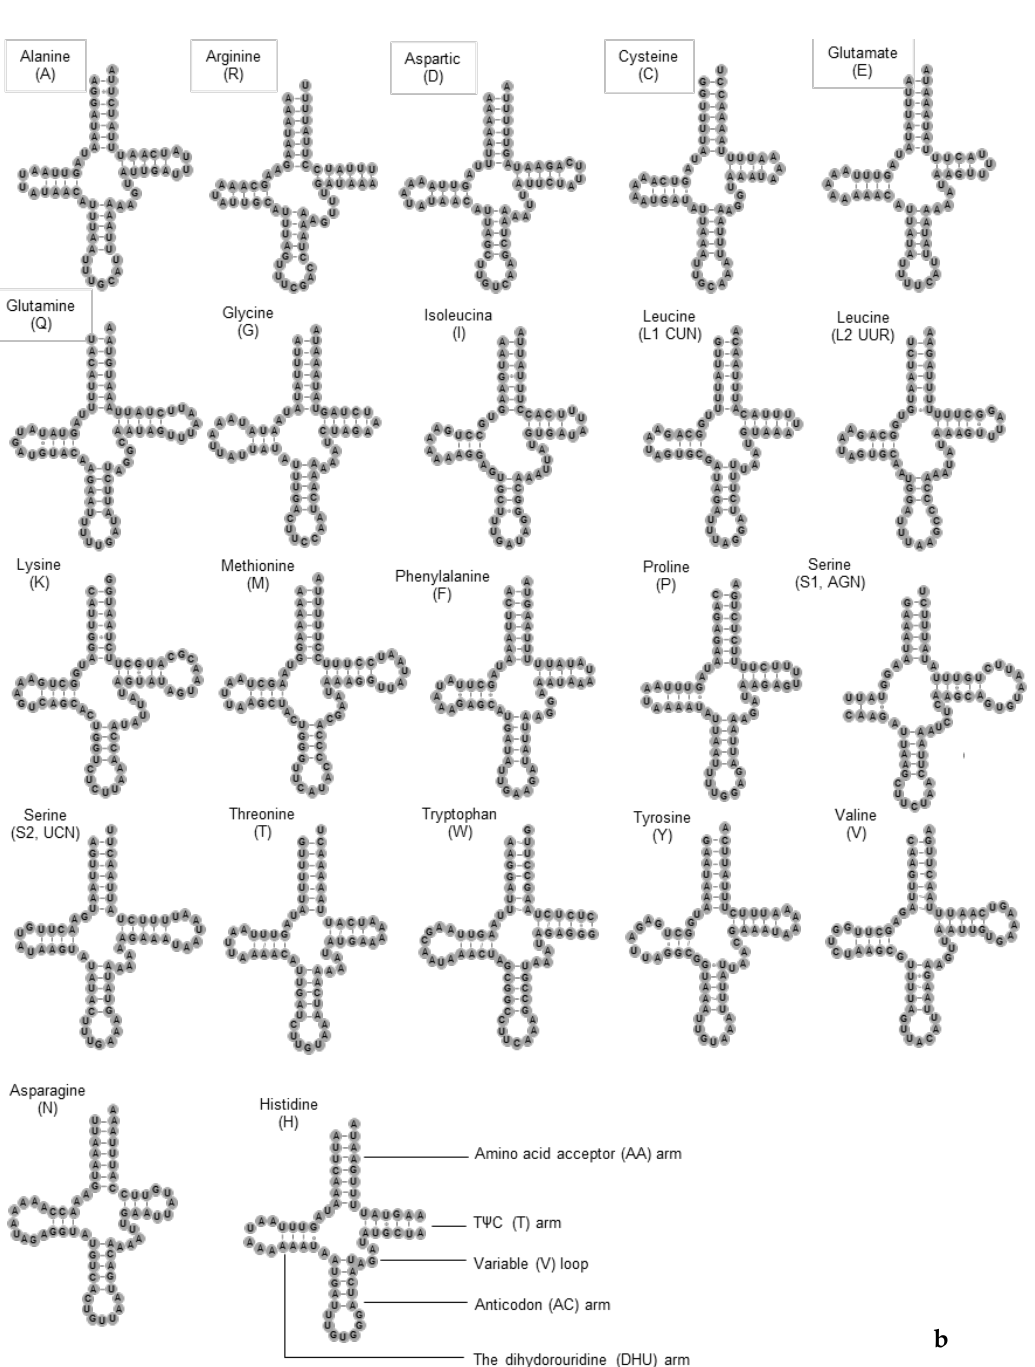
Figure 3. Putative secondary structures of tRNAs found in the mitochondrial genome of C. dimidiatus ( a ) and C. pilosellus ( b ).